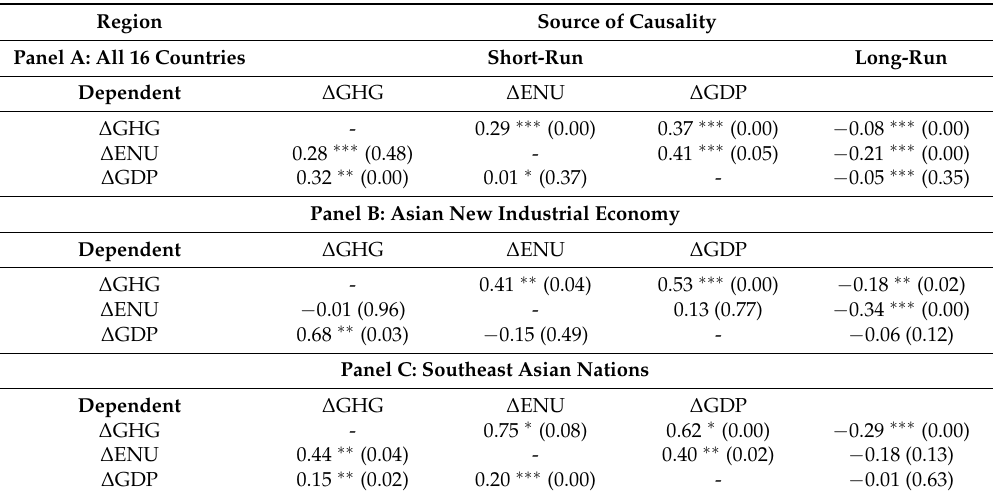
Table 6. Panel causality test